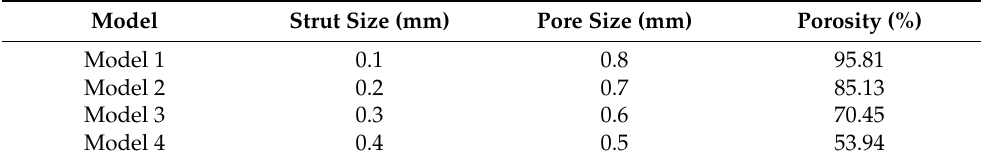
Figure 1. The 3D image of model 1 with the volume porosity of 70.45%. ( a ) Cube cell; ( b ) single-layer structure; ( c ) honey- comb structure. Table 1. Dimensions and volume porosities of honeycomb structures.